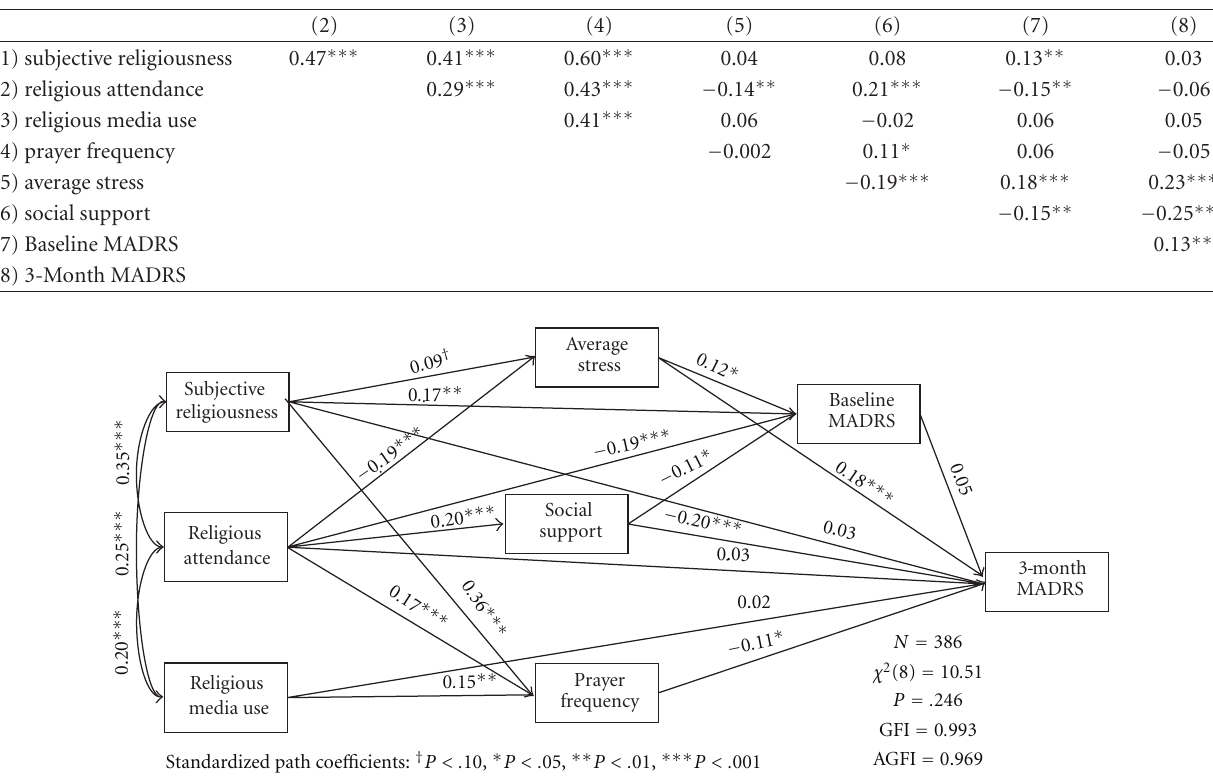
Figure 2: Path model with standardized coe ffi cients for structural equation model of religious factors, social support, stress, and baseline and 3-month depression severity. MADRS: Montgomery- ˚Asberg Depression Rating Scale. Based on a partial correlation matrix controlling for gender, race, age, education, religious denomination, and vascular comorbidity. All variables except 3-month MADRS were measured at baseline. Error terms for endogenous variables are not